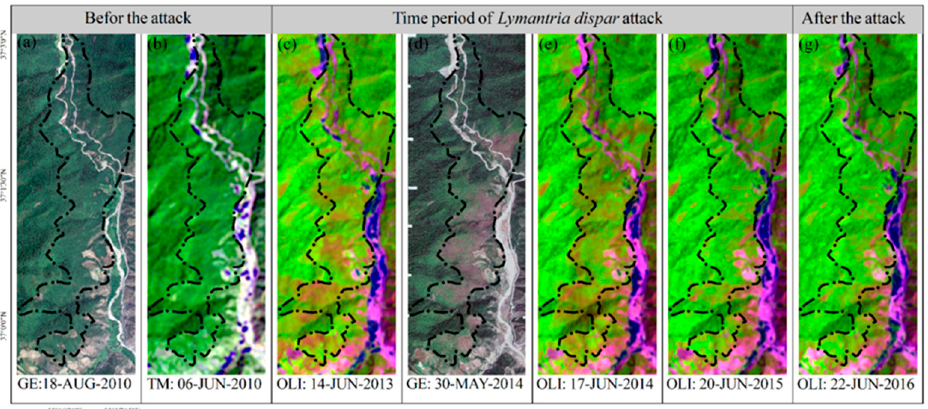
Figure 2. Site C (Figure 1): The images of Google Earth (GE) [59] and Landsat 5 TM (SWR, NIR, R) show that the forest was in a healthy condition before the attack of Lymantria dispar in 2010 ( a , b ); the symptoms of the infestation emerged on the Landsat 8 OLI (SWR1, NIR, R) as “olivenite green” in 2013 ( c ); the insect significantly infested the region based on the GE ( d ) and Landsat 8 OLI ( e ) images in 2014, while it declined in 2015 ( f ) and ended in 2016 ( g